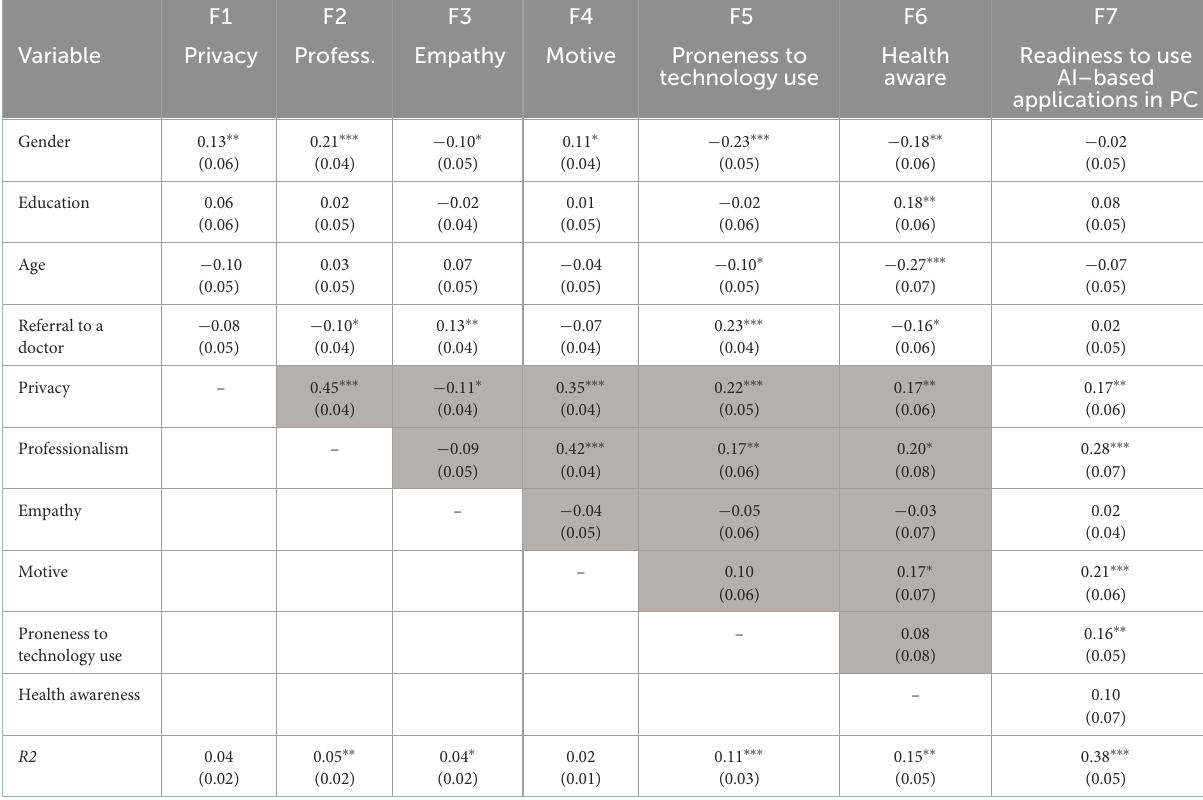
TABLE 3 Structural equation model results and standardized regression